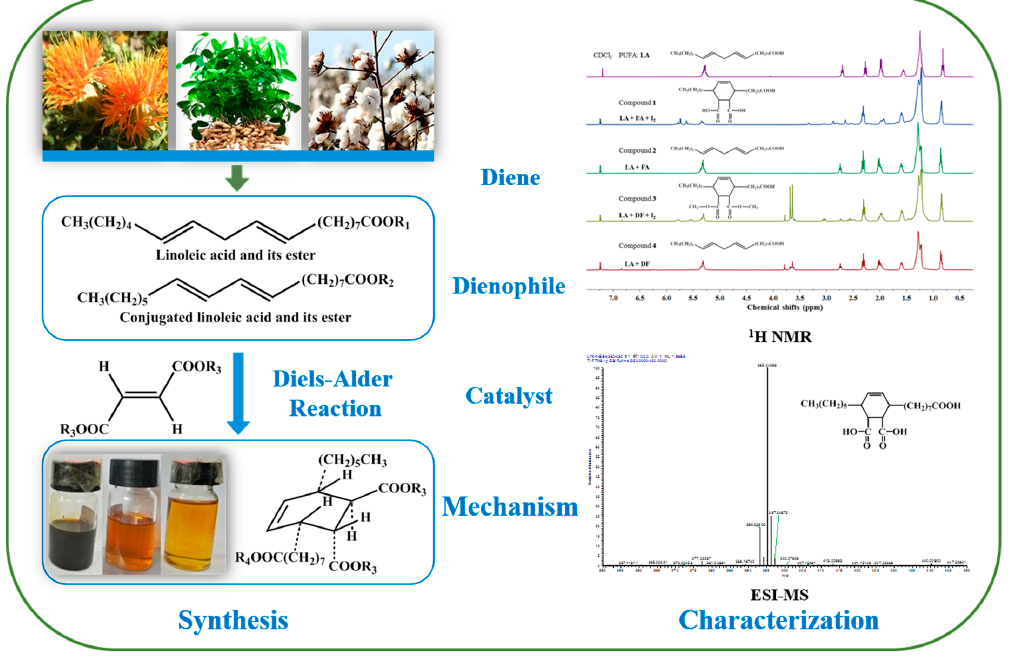
Figure S1: ESI-MS spectrum of compound 1 C22TA; Figure S2: ESI-MS spectrum of compound 3 C22TADME; Figure S3: ESI-MS spectrum of compound 5 C22TAMME; Figure S4: ESI-MS spectrum of compound 7 C22TATME; Figure S5: ESI-MS spectrum of compound 9 C22TADME; Figure S6: ESI-MS spectrum of compound 10 C22TADME; Figure S7: ESI-MS spectrum of compound 11 C22TAMEE; Figure S8: ESI-MS spectrum of compound 12 C22TAMEE; Figure S9: ESI-MS spectrum of compound 13 C22TADMMEE; Figure S10: ESI-MS spectrum of compound 14 C22TADMMEE; Figure S11: 1 H-NMR spectrum of compound 1 C22TA; Figure S12: 1 H-NMR spectrum of compound 3 C22TADME; Figure S13: 1 H-NMR spectrum of compound 5 C22TAMME; Figure S14: 1 H-NMR spectrum of compound 7 C22TATME; Figure S15: 1 H-NMR spectrum of compound 9 C22TADME; Figure S16: 1 H-NMR spectrum of compound 10 C22TADME; Figure S17: 1 H-NMR spectrum of compound 11 C22TAMEE; Figure S18: 1 H-NMR spectrum of compound 12 C22TAMEE; Figure S19: 1 H-NMR spectrum of compound 13 C22TADMMEE; Figure S20: 1 H-NMR spectrum of compound 14 C22TADMMEE; Figure S21: 13 C-NMR spectrum of compound 1 C22TA; Figure S22: 13 C-NMR spectrum of compound 3 C22TADME; Figure S23: 13 C-NMR spectrum of compound 5 C22TAMME; Figure S24: 13 C-NMR spectrum of compound 7 C22TATME; Figure S25: 13 C-NMR spectrum of compound 9 C22TADME; Figure S26: 13 C-NMR spectrum of compound 10 C22TADME; Figure S27: 13 C-NMR spectrum of compound 11 C22TAMEE; Figure S28: 13 C-NMR spectrum of compound 12 C22TAMEE; Figure S29: 13 C-NMR spectrum of compound 13 C22TADMMEE; Figure S30: 13 C-NMR spectrum of compound 14 C22TADMMEE.